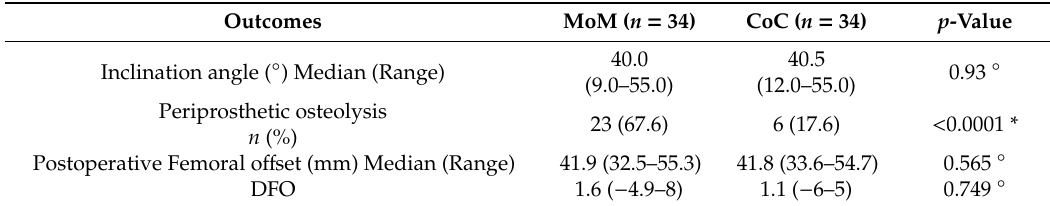
Table 3. Radiological outcomes.